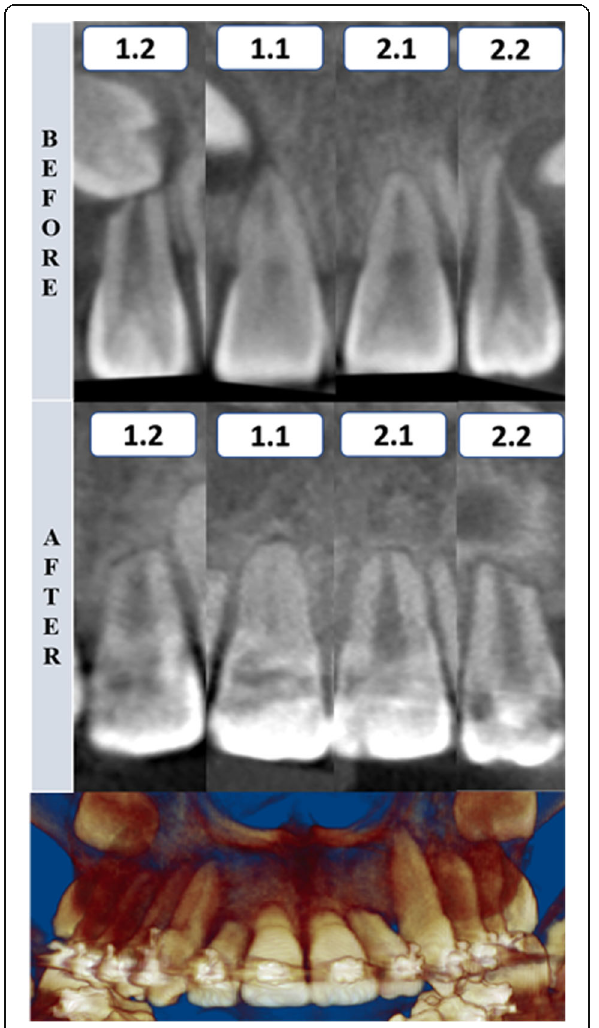
Fig. 8 Tomographic rendering after the canine traction and coronal section of maxillary incisors before and after the impacted canine traction — case 3. 1.2, maxillary right lateral incisor; 1.1, maxillary right central incisor; 2.1, maxillary left central incisor; 2.2, maxillary left lateral incisor